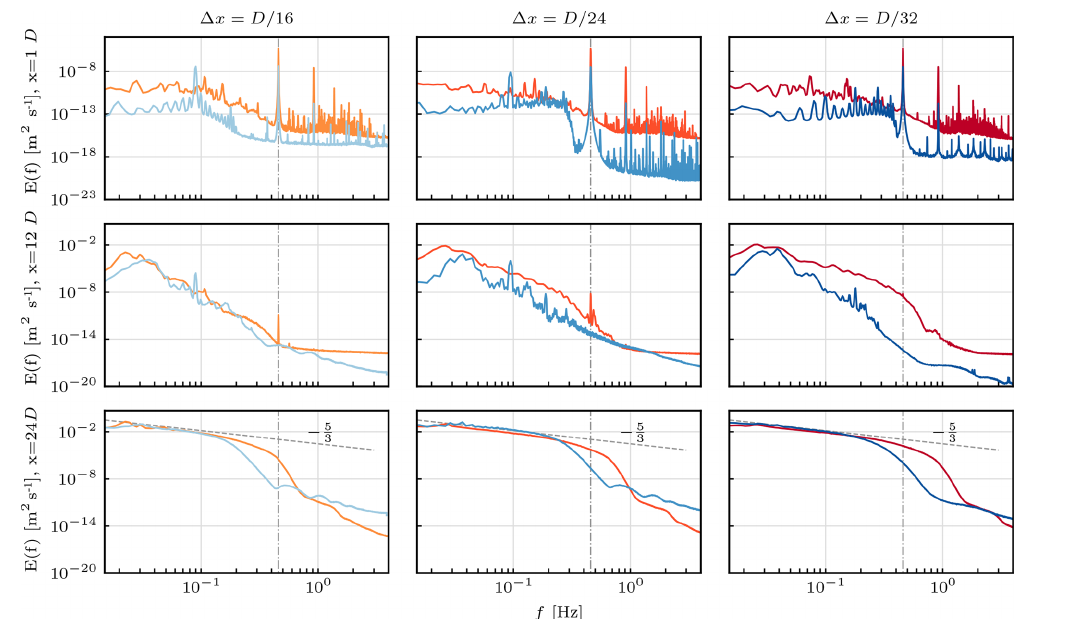
Figure 10. One-point turbulent kinetic energy spectra in the near ( x = 1 D , top) and far wake ( x = 12 D , middle; x = 24 D , bottom) at increasing spatial resolution from left to right. The vertical dashed–dotted line marks the blade-passing frequency f B = (3 u 0 λ ) / ( πD ) = 0 . 458Hz. Mind the change of scale on the y axis between the first and second rows of subplots. For the legend, see Fig. 5.